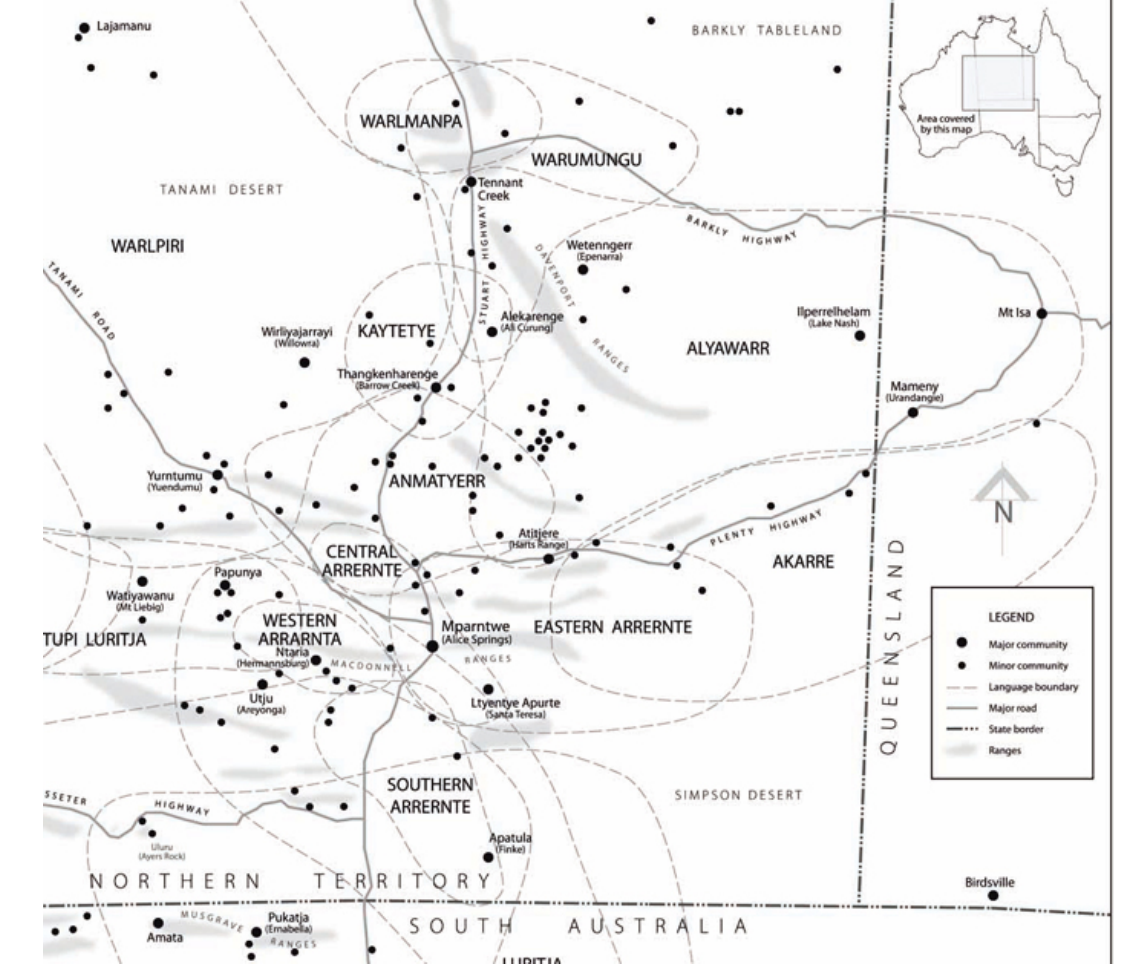
Fig. 1. Arrernte lands surround Mparntwe (Alice Springs) and encompass about 150,000 km 2 of land. Co- author, Veronica Dobson, is an Eastern Arrernte speaker. Arrernte lands neighbor other Arandic languages (Anmatyerr, Alyawarr, and Kayteye), Western Desert languages, (Pintupi/Luritja, Pitjantjatjara), and the Warlpiri language group. Large and small Aboriginal settlements are scattered across the central Australian region, with Alice Springs as their service center. Map by Brenda Thornley. Data from Institute for Aboriginal Development (IAD) Press